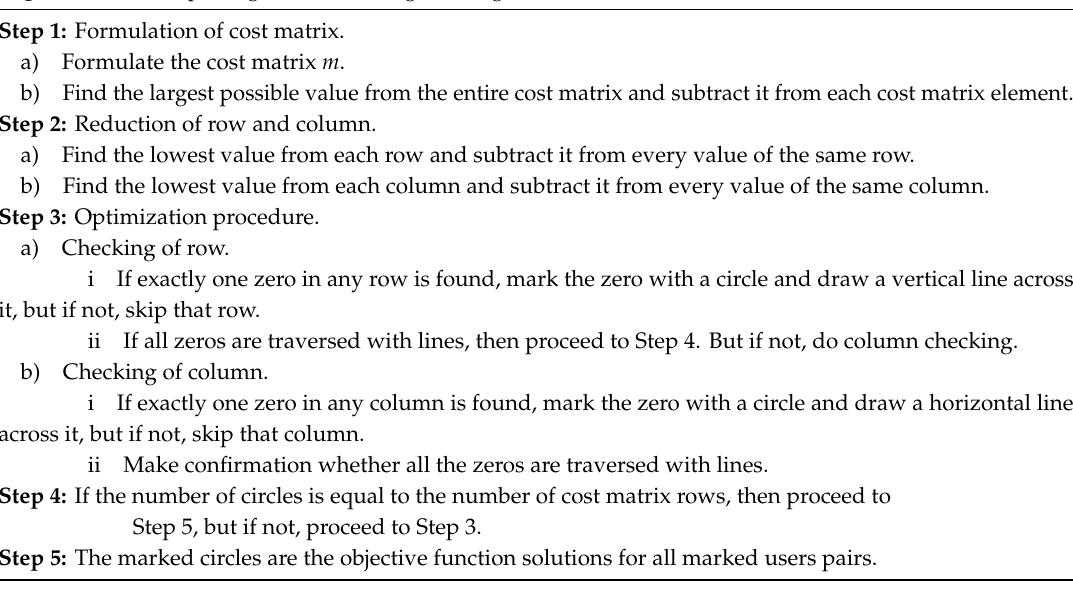
Algorithm 1. User pairing based on Hungarian algorithm